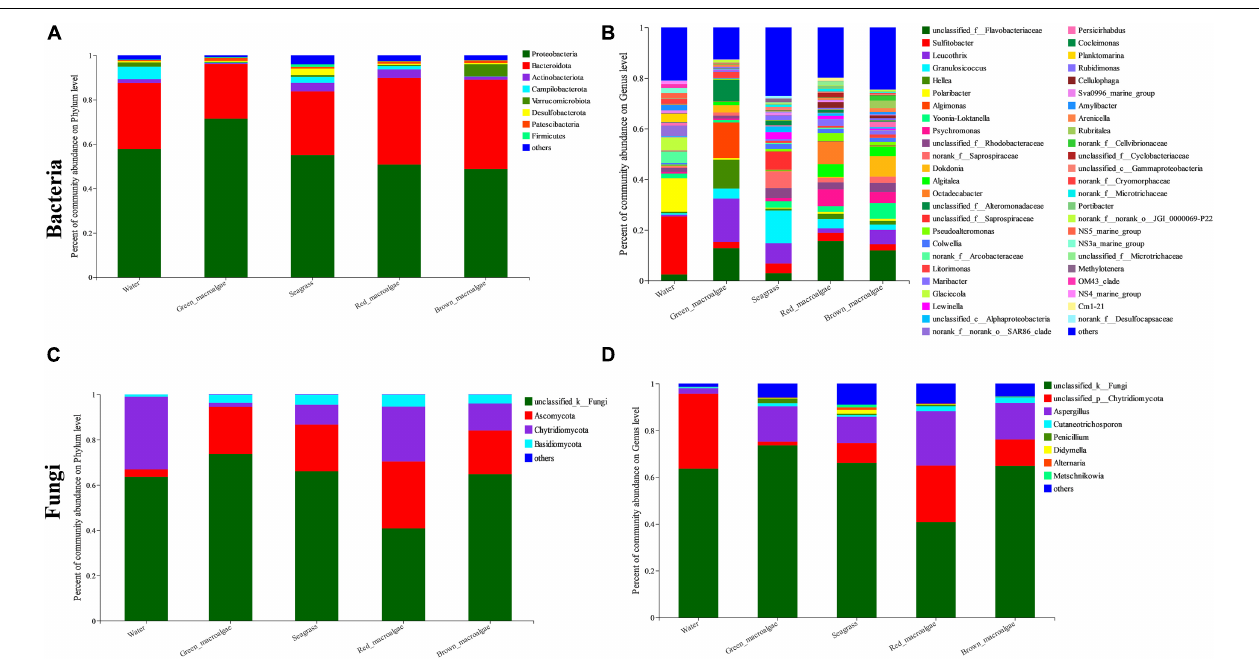
FIGURE 4 | Relative abundances of bacteria and fungi in seawater, green macroalgae, red macroalgae, brown macroalgae, and seagrass. (A) Bacterial community composition at the phylum level. (B) Bacterial community composition at the genus level. (C) Fungal community composition at the phylum level. (D) Fungal community composition at the genus